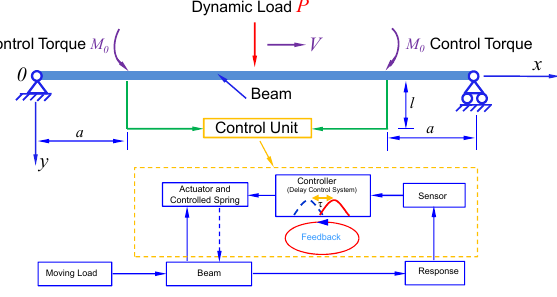
Figure 1. The simple controlled beam structure